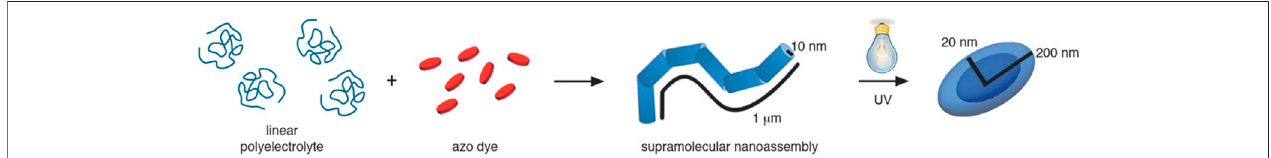
FIGURE 21 | Light switchable nano-object shape by electrostatic self-assembly: An anionic azo dye (Ay38) and a linear fl exible polyelectrolyte (PDADMA) for micrometer long thin fi bers which compactinto ellipsoidsupon irradiation (Mariani et al., 2018).Reprinted with permission. Copyright © 2018WILEY-VCH Verlag GmbH and Co. KGaA, Weinheim.